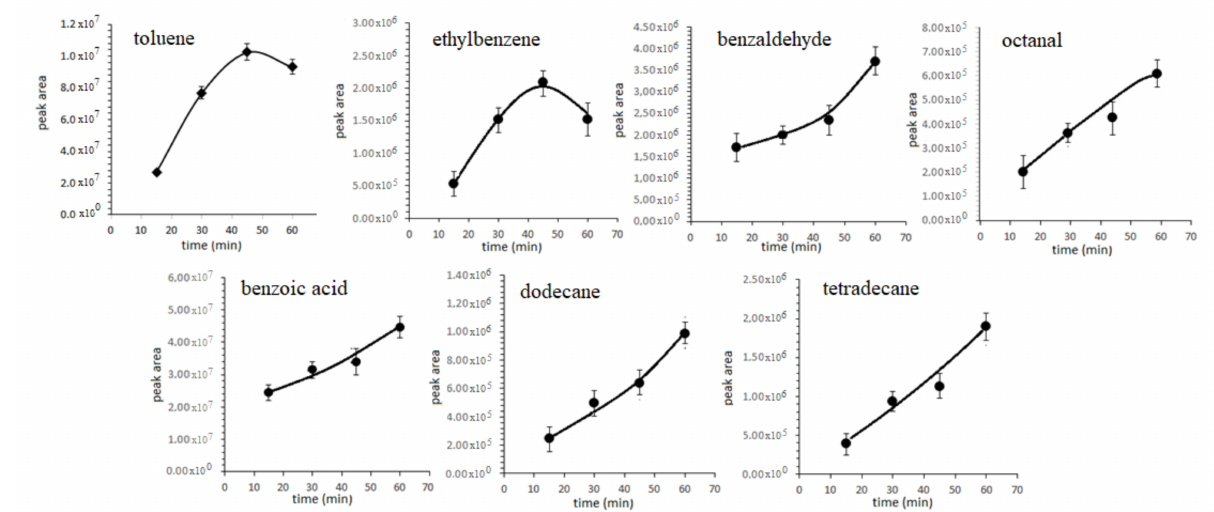
Figure 5. DI extraction time profiles obtained with the CAR/DVB/PDMS fiber at room temperature in the presence of 30% NaCl.